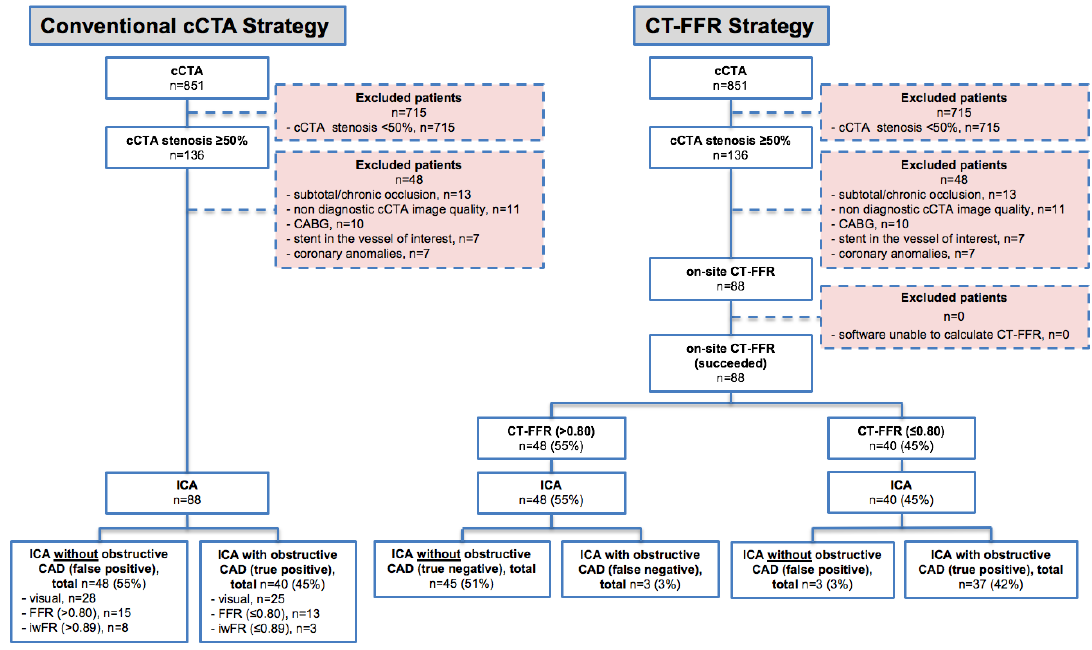
Figure 3. Study Flow-Chart. CT-FFR = CT-derived fractional flow reserve, cCTA = coronary computed tomography angiography, ICA = invasive coronary angiography, CAD = coronary artery disease, CABG = coronary artery bypass graft.